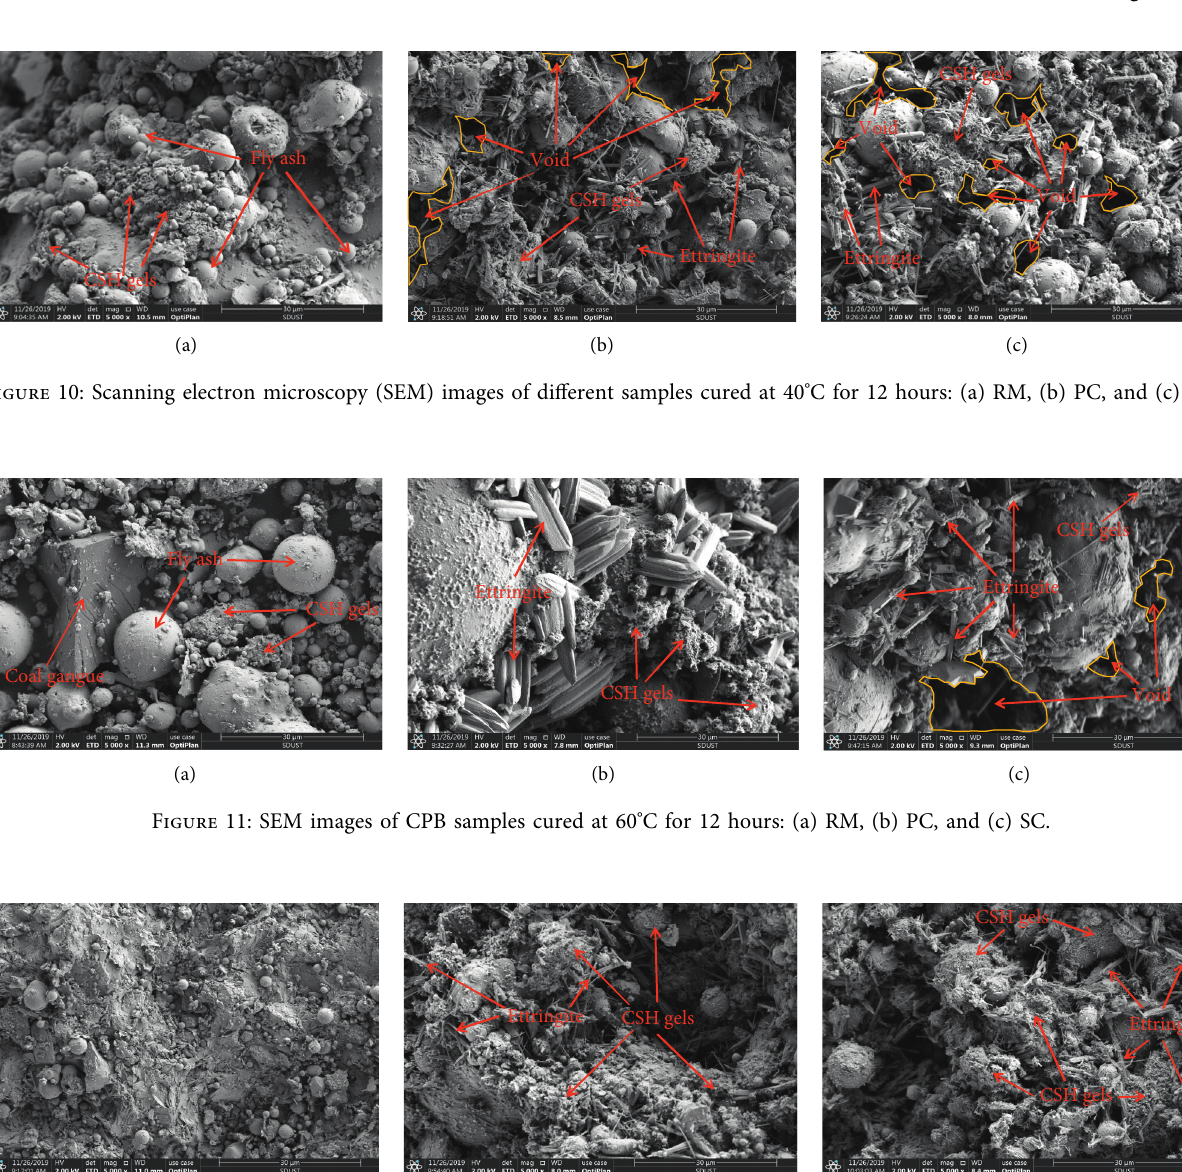
Figure 12: SEM images of different samples cured at 80 ° C for 12h: (a) RM, (b) PC, and (c)